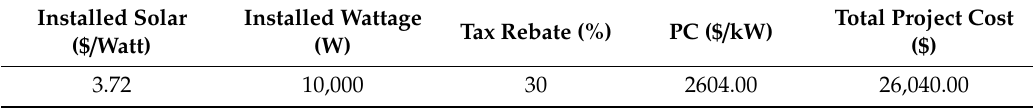
Table 5. The investment costs 10 kW equipment (USA-California).